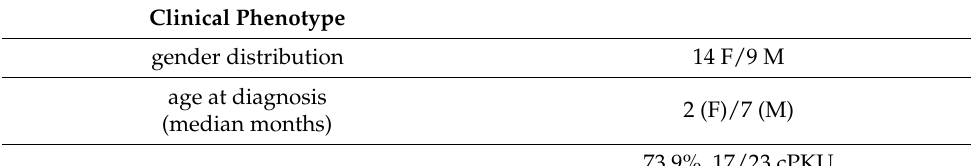
Table 1. Phenotypic features of our